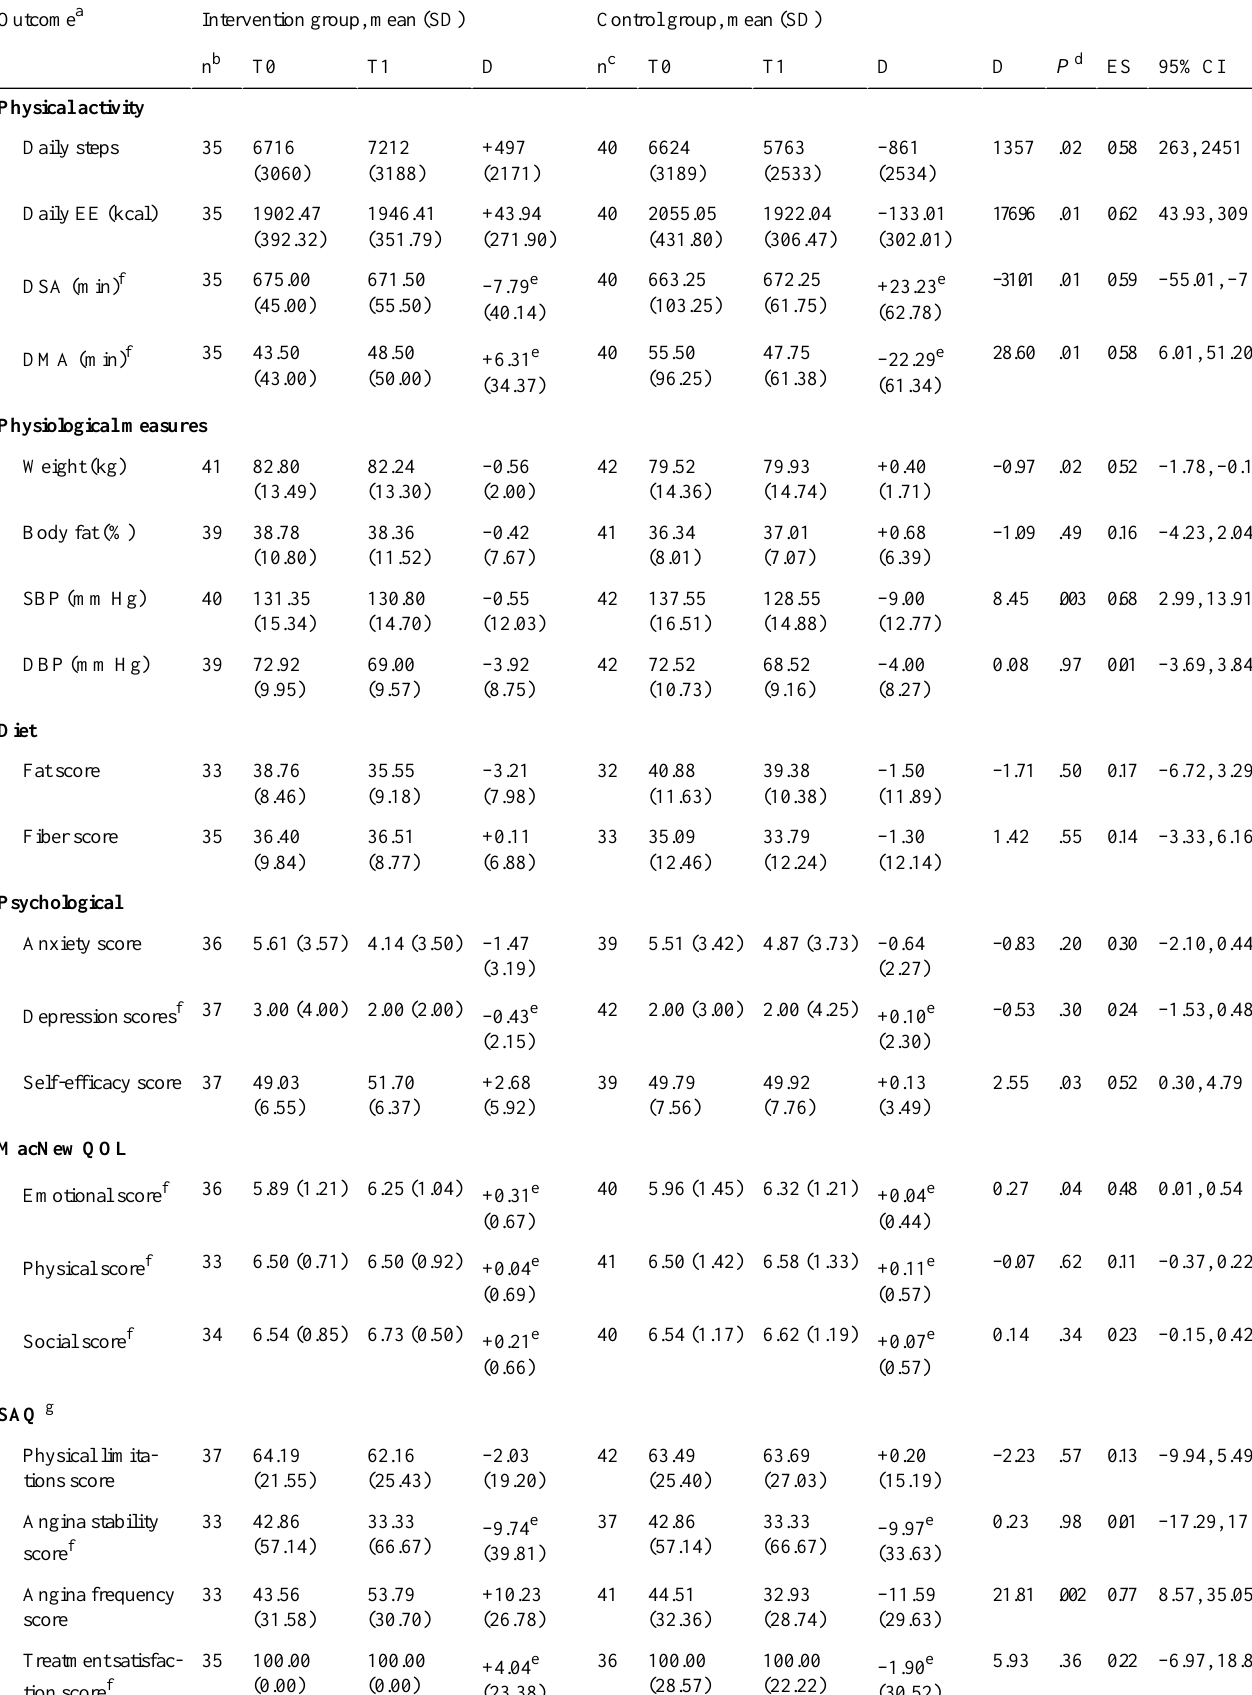
Table 2. Short-term intervention effects at baseline (T0) and 6-week follow-up (T1) for the intervention and control groups, including within- and between-group differences